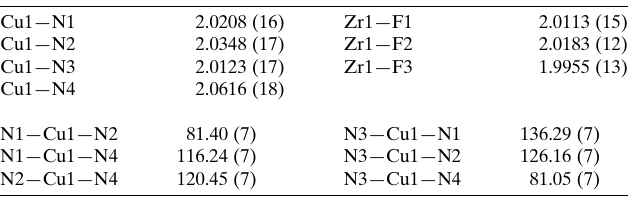
Table 1 Selected geometric parameters (A˚ , (cid:4) ) for